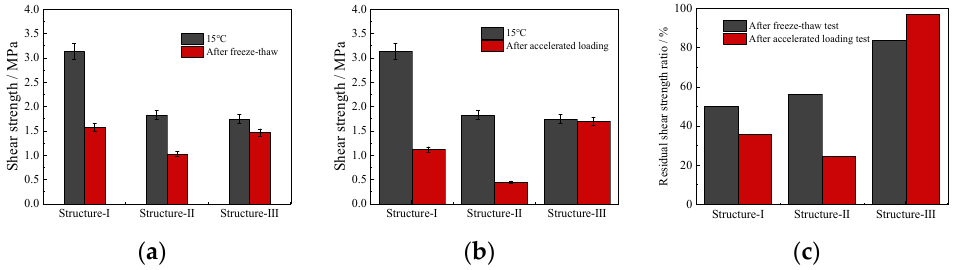
Figure 11. Shear strength under different working conditions. ( a ) After freeze–thaw. ( b ) After accelerated loading. ( c ) Residual shear strength ratio. According to the data in Figure